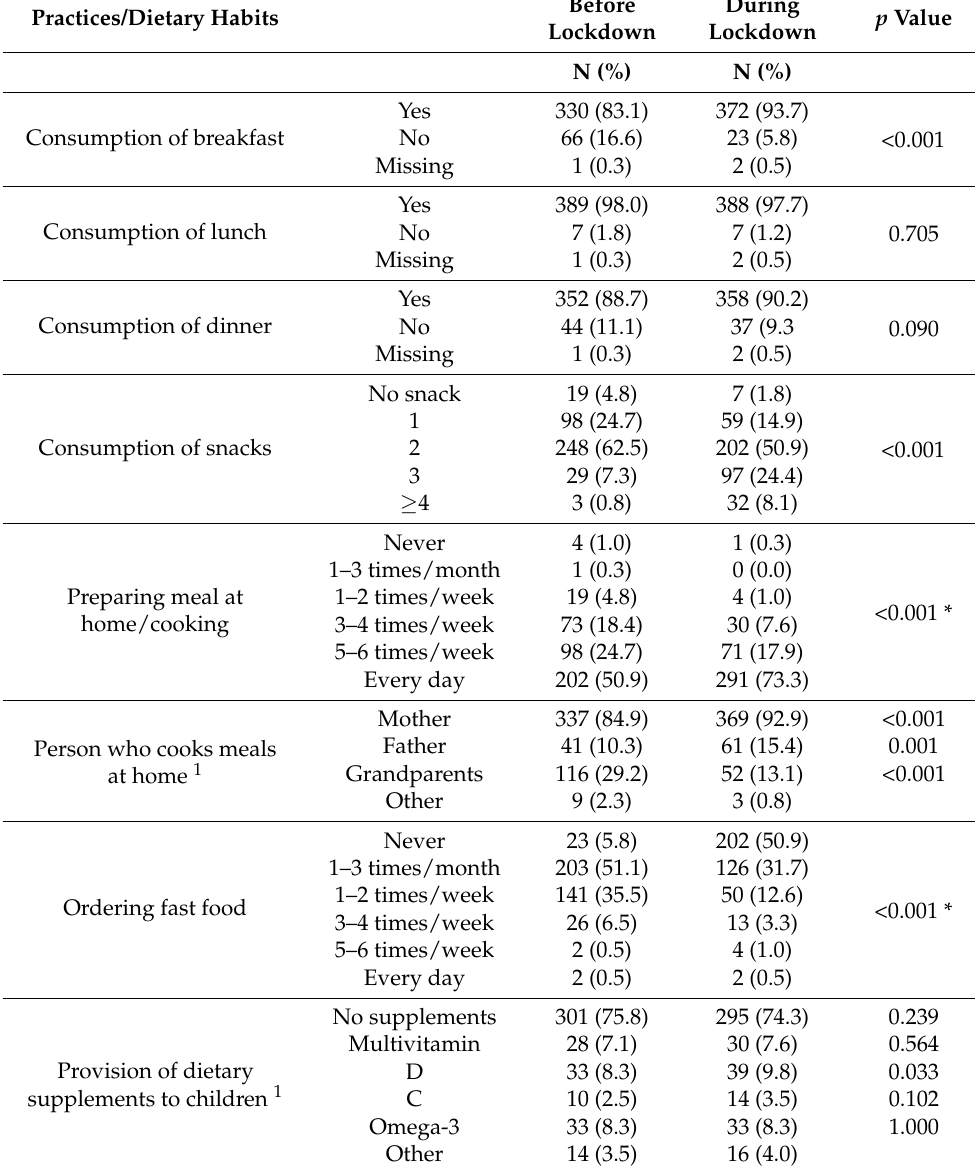
Table 3. Changes in parents’ food practices and dietary habits ( n 397). Practices/Dietary Habits